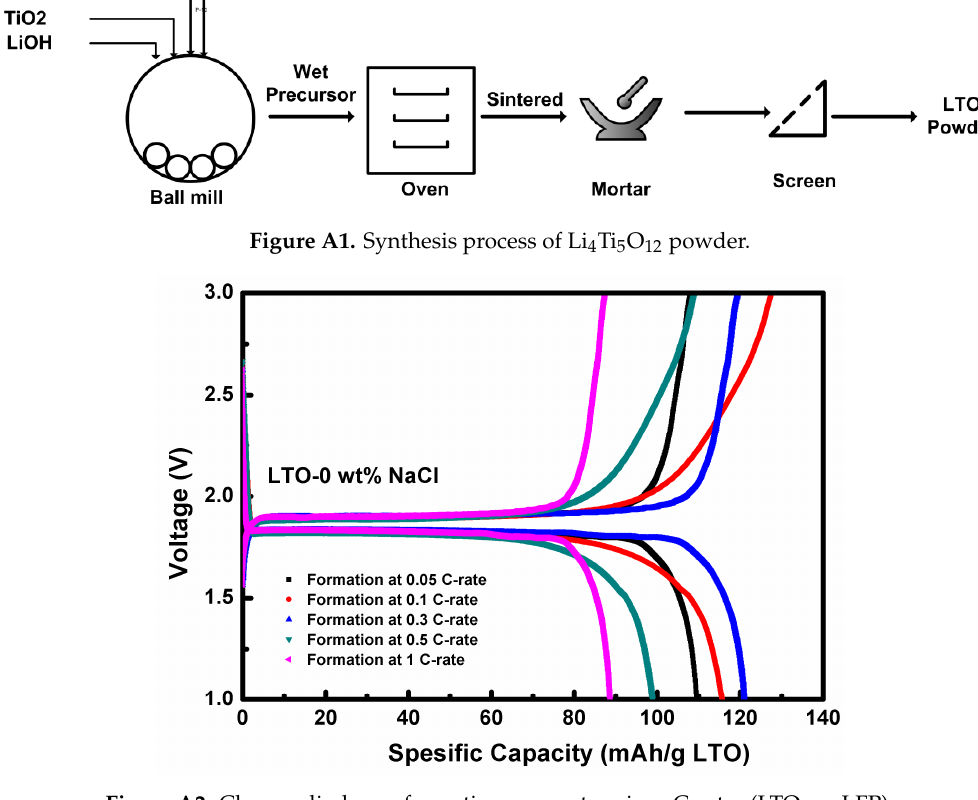
Figure A2. Charge–discharge formation curve at various C-rates (LTO vs. LFP).